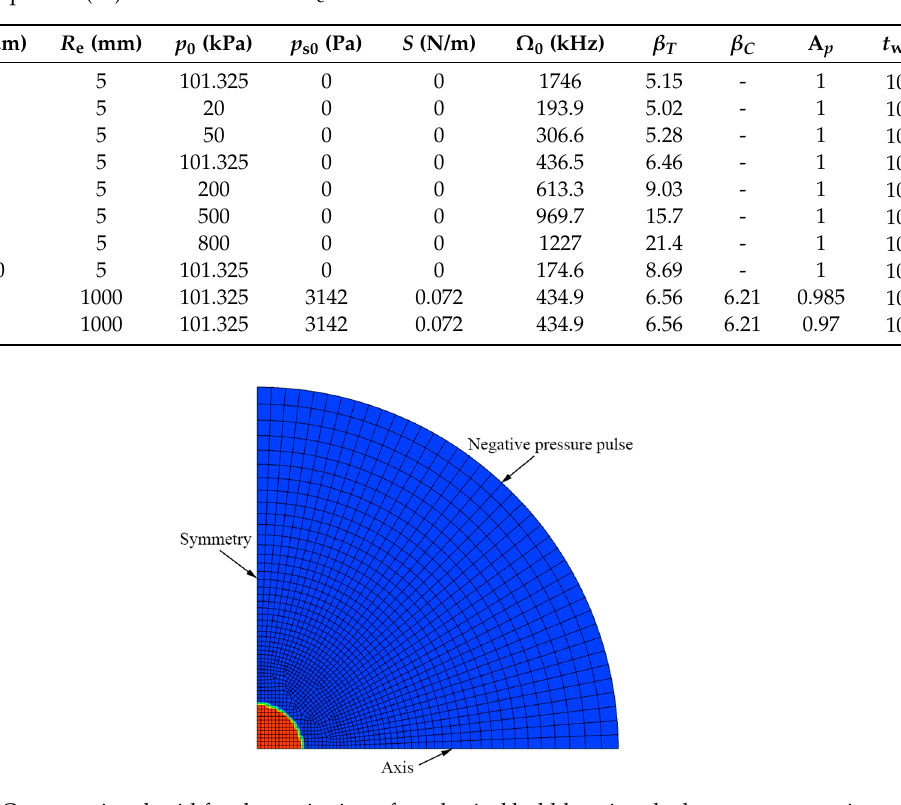
Figure 1. Computational grid for the cavitation of a spherical bubble using the homogeneous mixture model. The gas phase distributes inside the region marked in red.